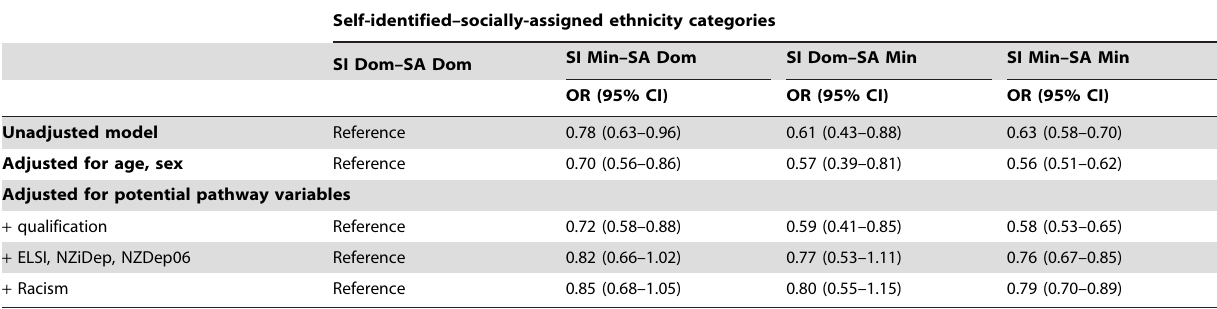
Table 6. Odds of reporting excellent/very good health (compared to good/fair/poor health) for the self-identified–socially- assigned ethnicity